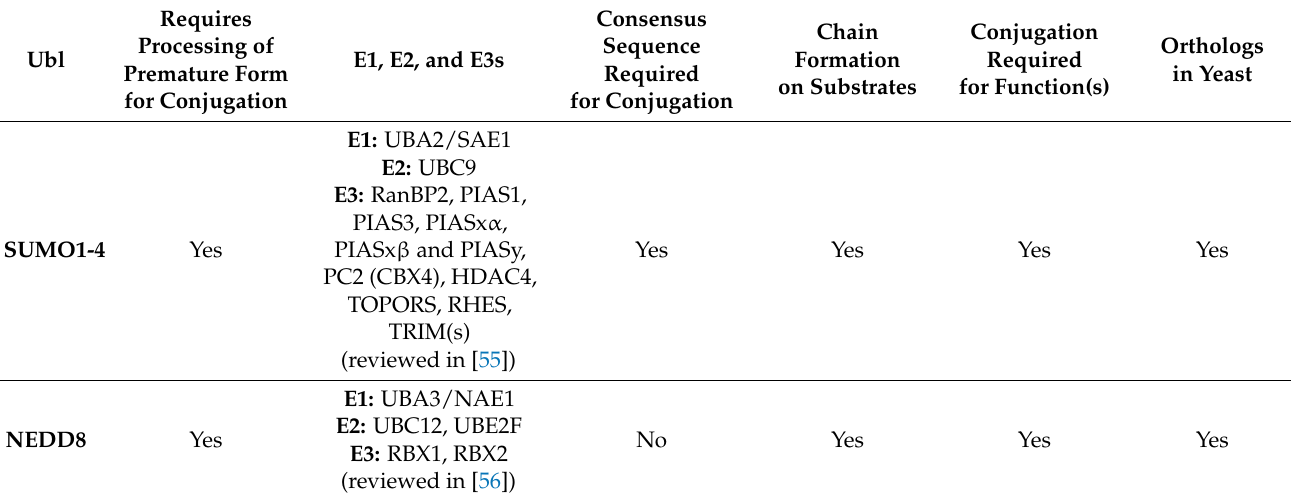
Table 1. Ubiquitin-like proteins: processing and